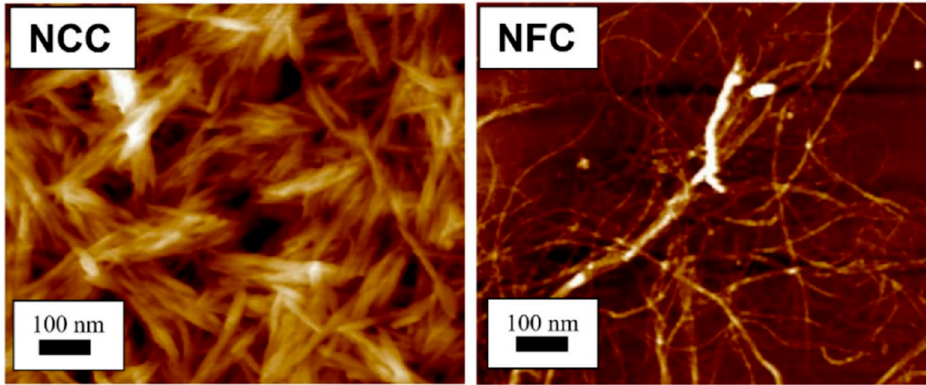
Figure 1. Atomic force microscopy images show different structures between nanocrystalline cellulose (NCC) and nanofibrillated cellulose (NFC).